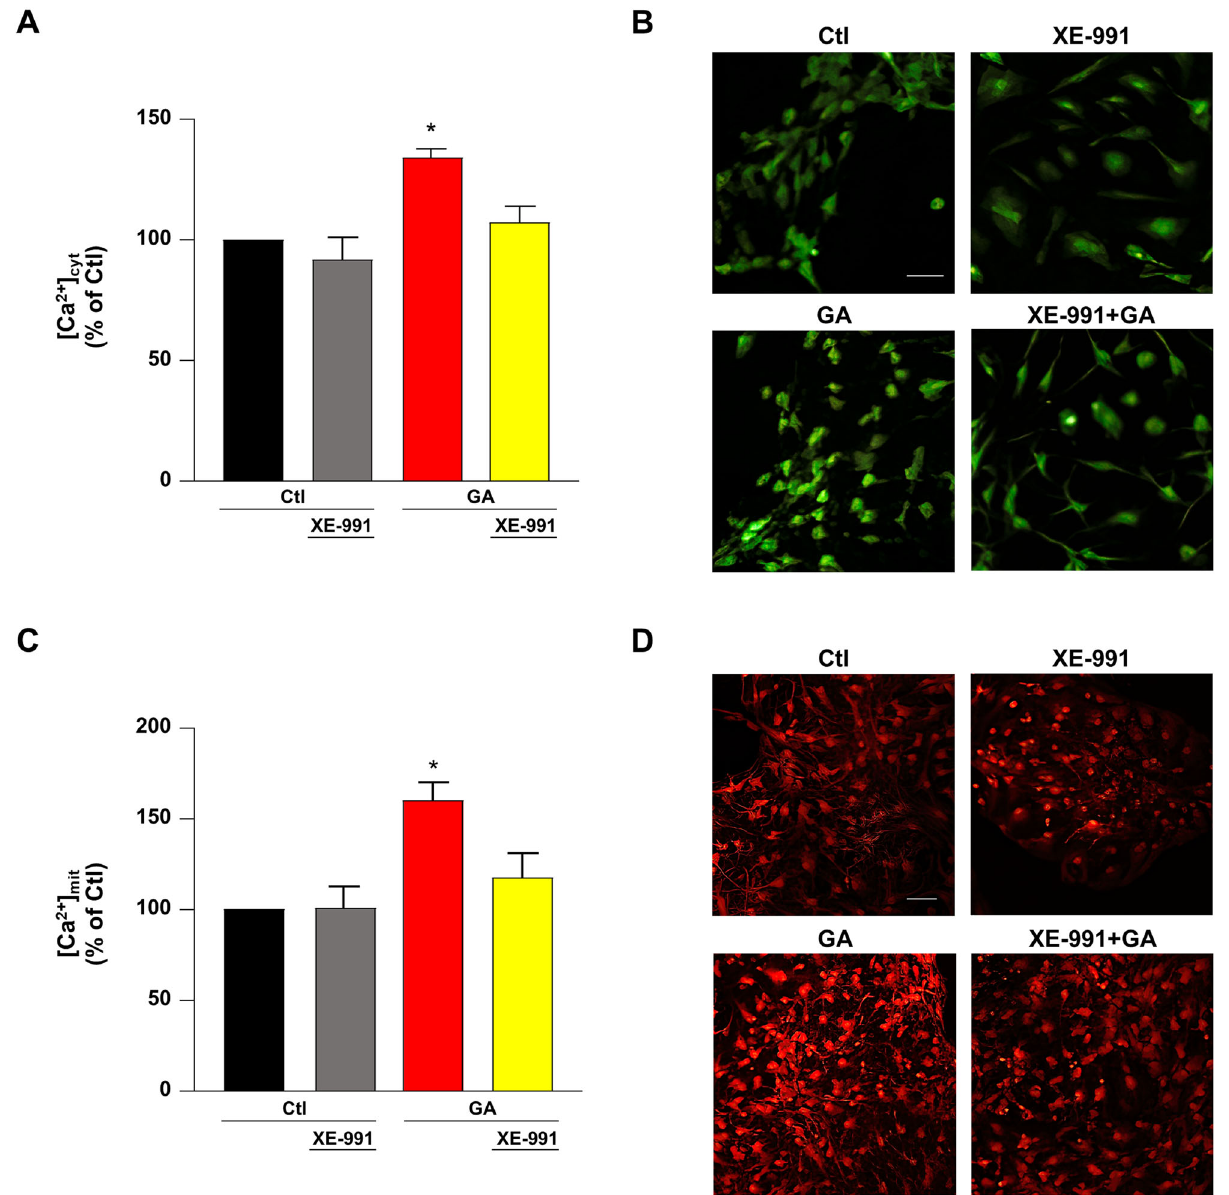
Fig. 3 Evaluation of the effect of XE-991 on the increase in cytoplasmic and mitochondrial Ca 2 + levels induced by GA in primary rat cortical neurons. A , C The bar plots depict average data of the cytoplasmic ( A ) and mitochondrial ( C ) basal Ca 2 + levels. The fl uorescence intensity is transformed into calibrated [Ca 2 + ] by applying the following equation: [Ca 2 + ] = Kd (F − F min ) / (F max − F) where Kd is the Ca 2 + dissociation constant of the indicator (Kd Fluo-4-AM = 345 nM; Kd Rhod-2-AM = 570 nM); F min and F max represent the intensities of fl uorescence at zero and saturating [Ca 2 + ], respectively; and F represents the intensity of fl uorescence at any given time. In each experiment, [Ca 2 + ] was expressed as control percentage. B , D Representative images of the basal Ca 2 + levels within cytoplasm ( B ) and mitochondria ( D ). Scale bar 50 µm. Differences were evaluated by one-way ANOVA followed by Dunnett ’ s post hoc test. A F (3, 10) = 11.67. For each experimental group, the statistical analysis was performed by using the basal values derived from three independent experiments, and 100 – 150 cells were recorded for each session. *Signi fi cant versus all groups ( p < 0.01 versus Ctl, p < 0.001 versus XE-991, and p < 0.05 versus XE- 991 + GA). C F (3, 15) = 8.091. For each experimental group, the statistical analysis was performed by using the basal values derived from at least four independent experiments, and 100 – 150 cells were recorded for each session. *Signi fi cant versus all groups ( p < 0.01 versus control groups and p < 0.05 versus XE-991 +